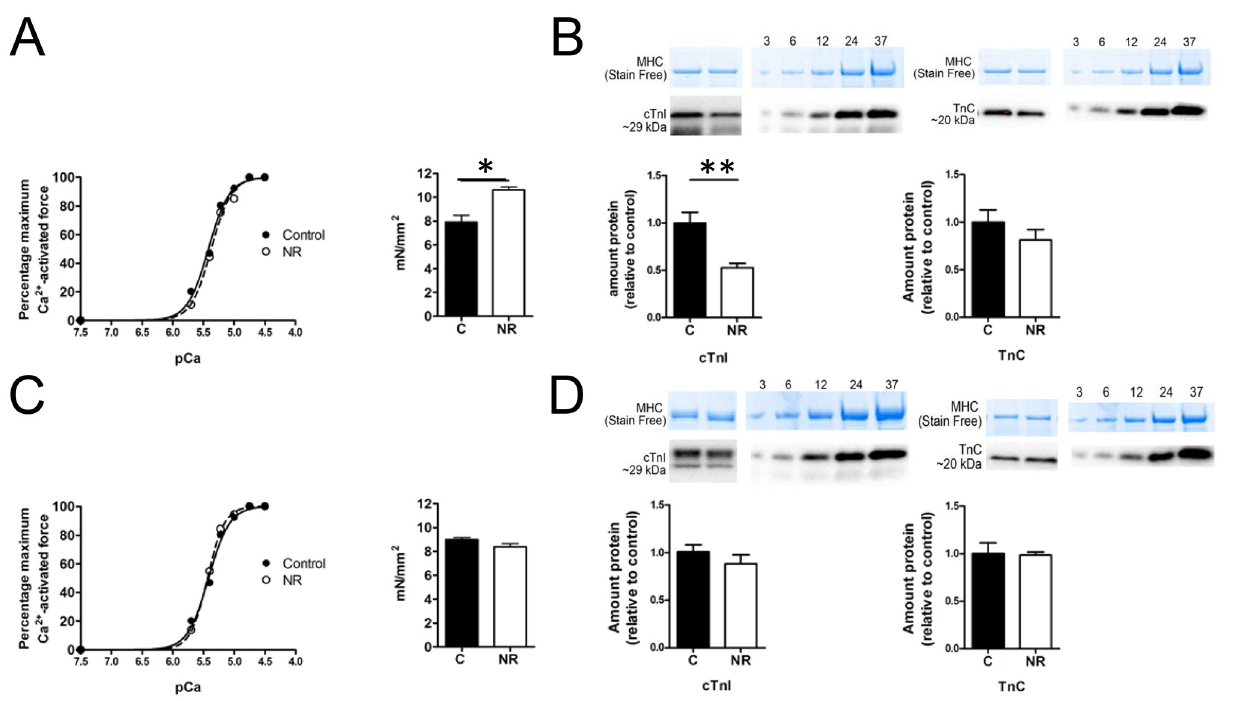
Fig 6. Ca 2+ sensitivity of the contractile apparatus and maximum Ca 2+ -activated force. (A) Representative force-pCa curves from left ventricular bundles for male control and NR rats. Pooled data showed no statistical difference between control (n = 10) or NR (n = 10) in pCa 50 or Hill coefficient. However, values of maximum Ca 2+ -activated force from the same samples showed a significant increase in maximum force produced by NR heart samples (C: 7.9 mN/mm 2 ± 0.59 vs NR: 10.57 ± 0.25; F (1,8) = 8.925, * P < 0.05).(B) Quantitative analysis of integral proteins associated with the contractile apparatus in male offspring. Male C (n = 10) and NR (n = 8) showed no significant difference in the relative amount of TnC, however there was a reduction in the amount of cTnI from NR samples, showing a significant decrease compared with controls (unpaired t-test, * P < 0.05). (C) Representative force-pCa curves for female control and NR rats. Pooled data showed no significant differences between control (n = 10) or NR (n = 10) for either pCa 50 or Hill coefficient. Maximum Ca 2+ - activated force was similar between treatments. (C: 8.98 mN/mm 2 ± 0.18 vs NR: 3.38 ± 0.27; F (1,8) = 2.966, P > 0.05). (D) Quantitative analysis of integral proteins associated with the contractile apparatus in female offspring. No differences were observed between female C (n = 8) and NR (n = 10) samples. Proportion of cTnI proteolytic fragmentation was unchanged between treatments for either sex (see results).